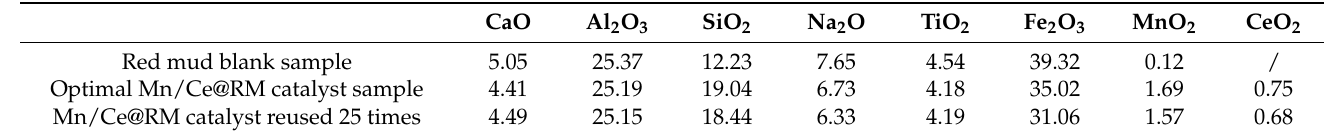
Table 3. XRF characterization results